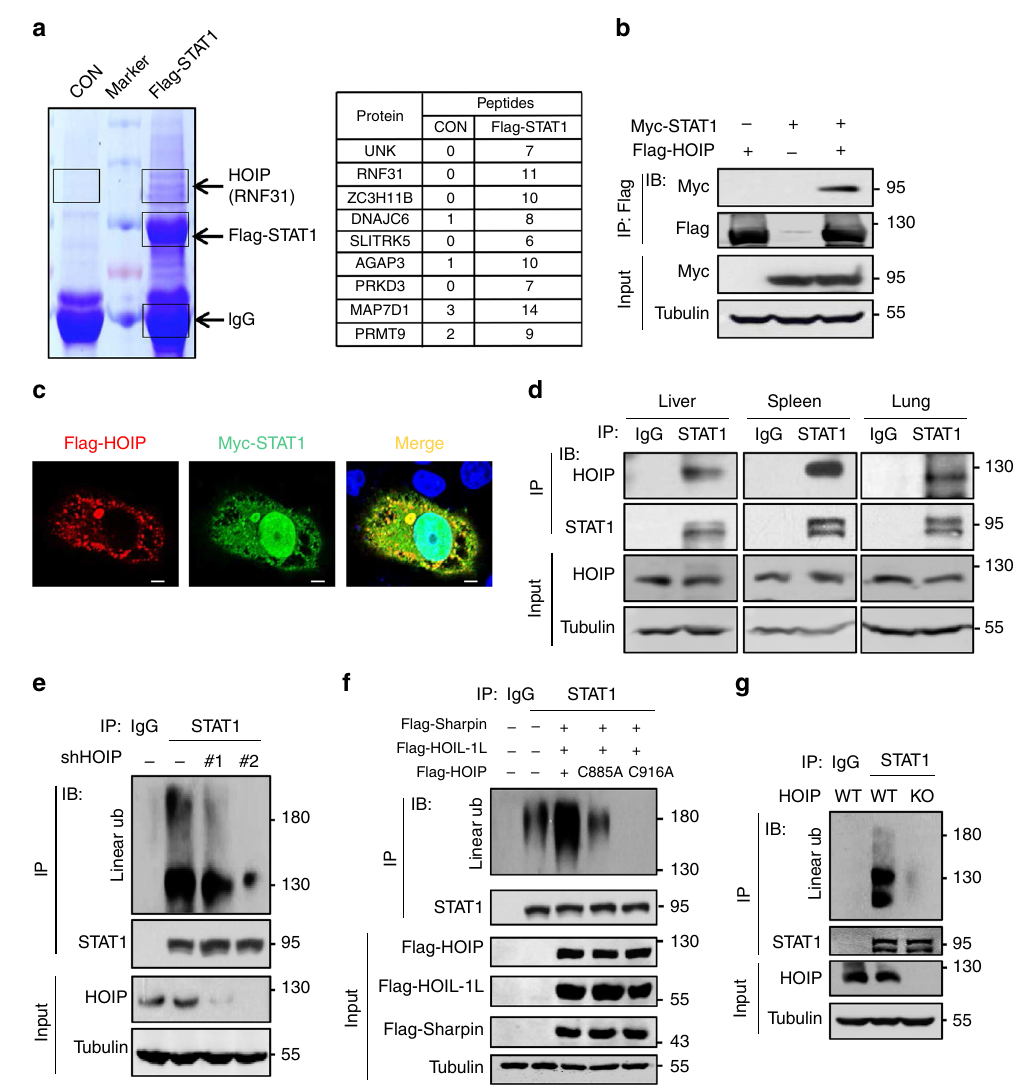
Fig. 1 STAT1 harbors linear ubiquitination mediated by HOIP. a Mass spectrometry analysis of the potential Flag-STAT1-binding proteins. The number of the identi fi ed peptides from the interacting proteins, including HOIP (RNF31), were shown as indicated. CON: control vectors. b Immunoprecipitation (IP) and immunoblotting (IB) analysis of the interaction between Flag-HOIP and Myc-STAT1 in HEK293T cells. c Immuno fl uorescence analysis of the interaction between Flag-HOIP and Myc-STAT1 in HeLa cells. Scale bar: 1 µ m. d Immunoprecipitation analysis of the interaction between endogenous STAT1 and HOIP in mouse primary liver, spleen, and lung cells. e Immunoprecipitation analysis of linear ubiquitination of endogenous STAT1 in HEK293T cells transfected with either control shRNAs ( – ) or two different shRNAs against HOIP (shHOIP #1, #2). Ub ubiquitination. f Immunoprecipitation analysis of linear ubiquitination of STAT1 in HEK293T cells cotransfected with Flag-HOIL-1L and Flag-Sharpin, together with Flag- HOIP wild-type or its catalytically inactivated mutants (C885A and C916A). g Immunoprecipitation analysis of linear ubiquitination of endogenous STAT1 in HOIP-wild-type (WT) or HOIP-knockout (KO) HEK293T cells. Data are representative of three independent